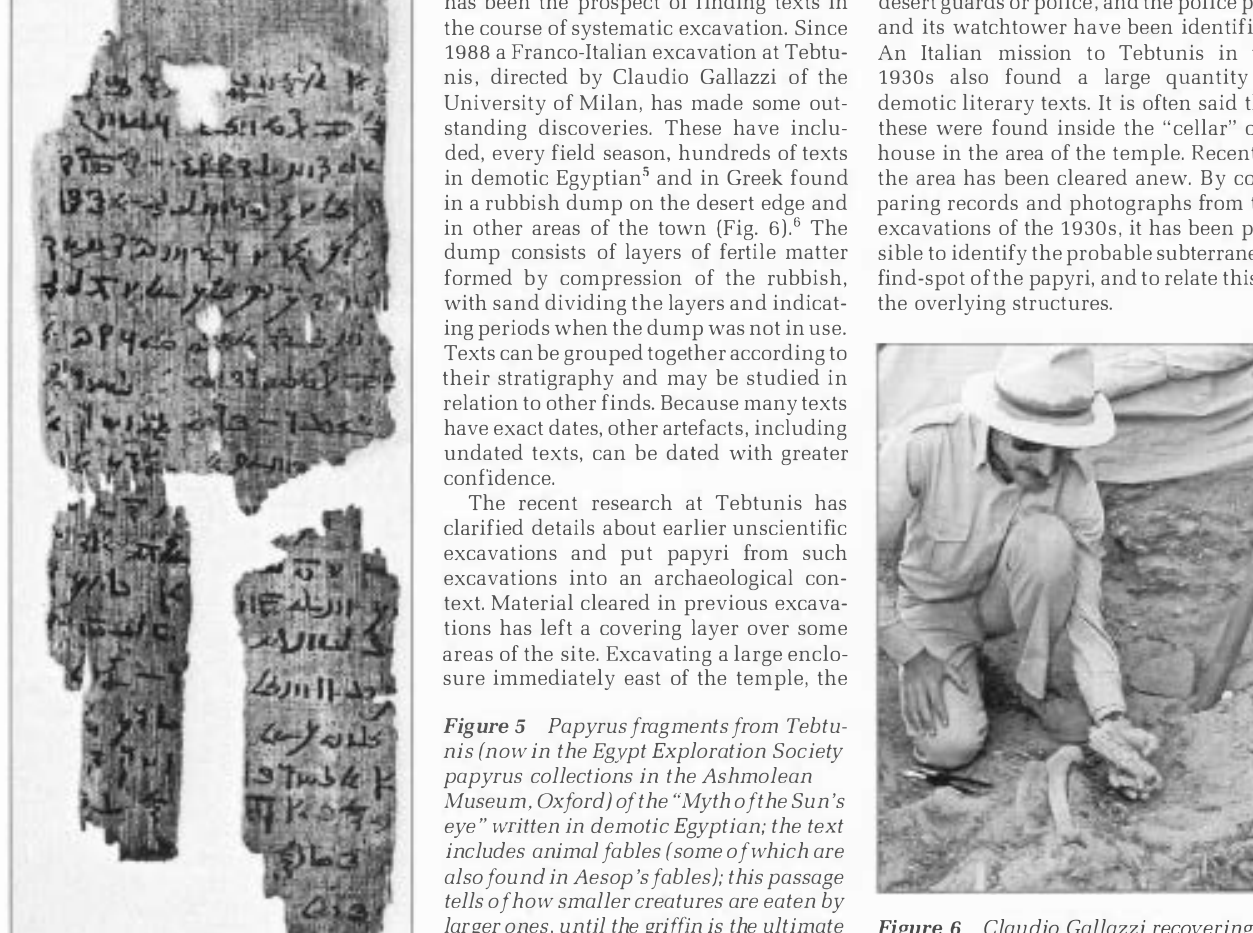
Figure 6 Claudio Gallazzi recovering a documentary roll of papyrus from the tem­ ple area at Tebtunis, November